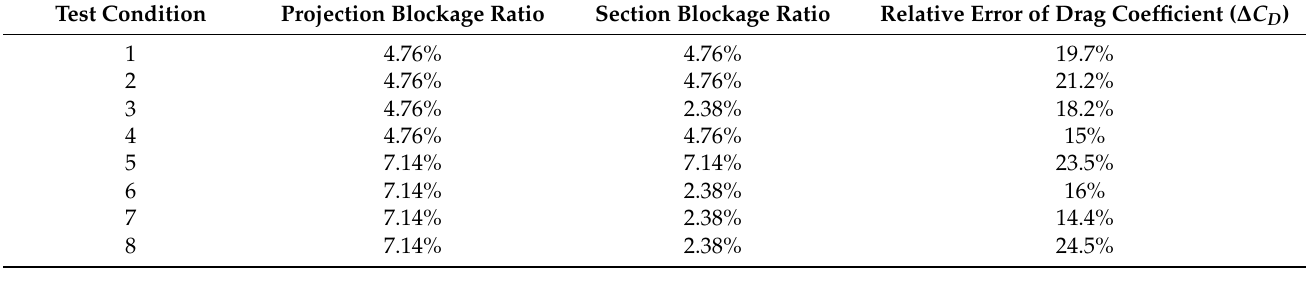
Table 5. The relative error of drag coefficient of the medium model.